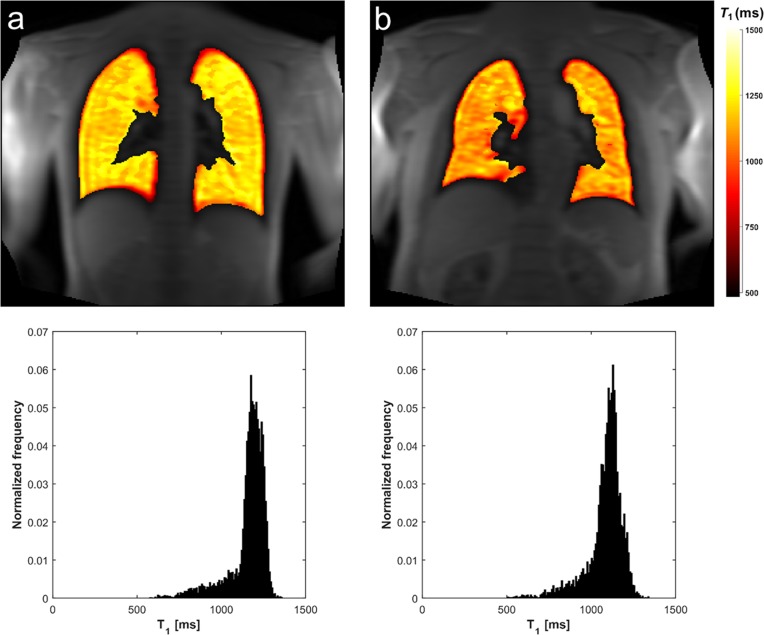
Lung T1 maps in a young and old never smoker.Representative coronal lung MRI T1 maps overlaid on a signal intensity image with corresponding normalized T1 histograms for a 25 years old (a) and a 60 years old (b) never smoker.